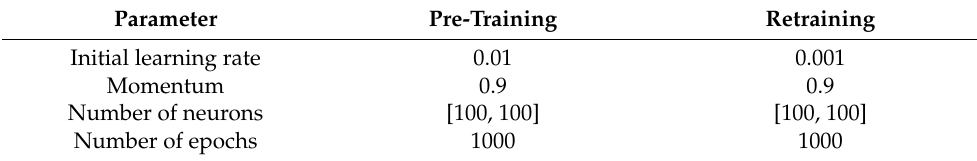
Table 2. Parameter values used in LSTM pre-training and LSTM-ETL retraining. Parameter